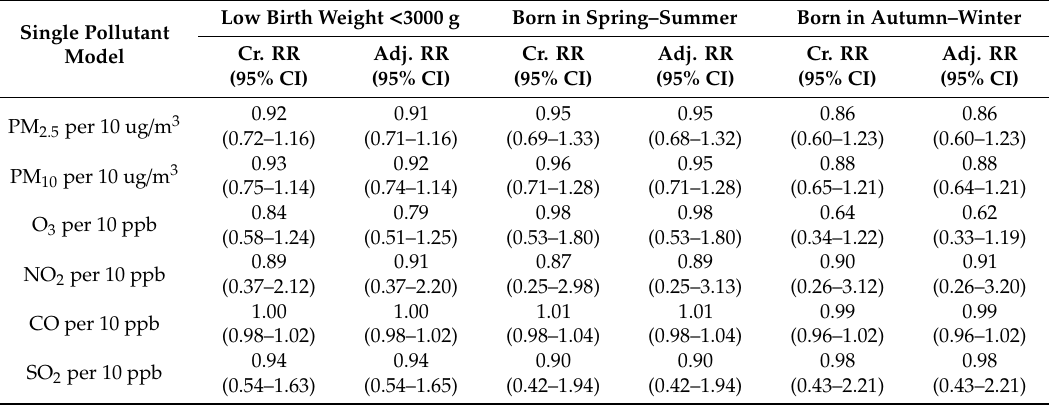
Table A1. The e ff ect of air pollution exposure during entire pregnancy per 10 unit increase in concentration on low birth weight less than 3000 g (N = 2517), The Espoo Cohort Study,